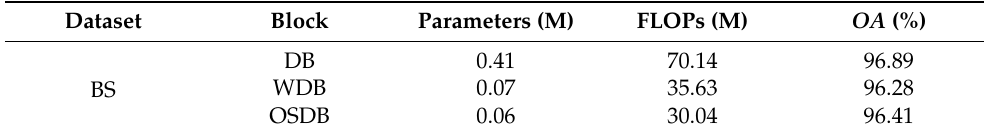
Table 19. The number of parameters, FLOPs, and OA of different dense blocks on the BS dataset. Dataset Block